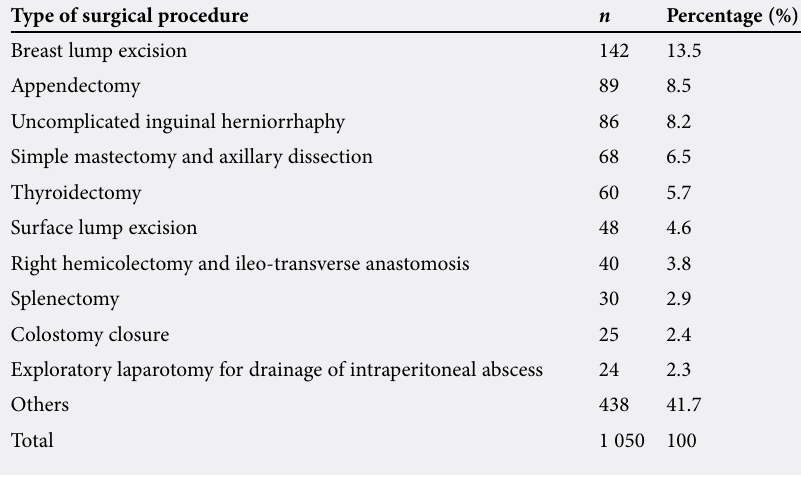
Table 1. Types of surgical procedure performed during the study period Type of surgical procedure